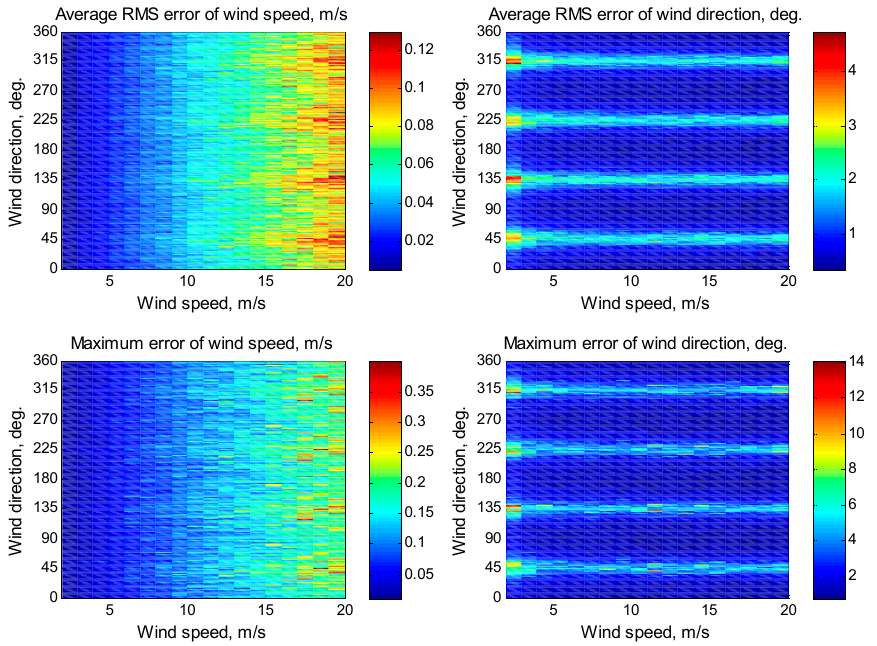
Figure 4. Simulation results for the mounting angle of a beam axis in the horizontal plane of 45° with the assumption of 0.1 dB instrumental noise at wind speeds of 2–20 m/s for the incidence angle of 30° with 5000 averaged NRCS samples for each azimuthal angle.